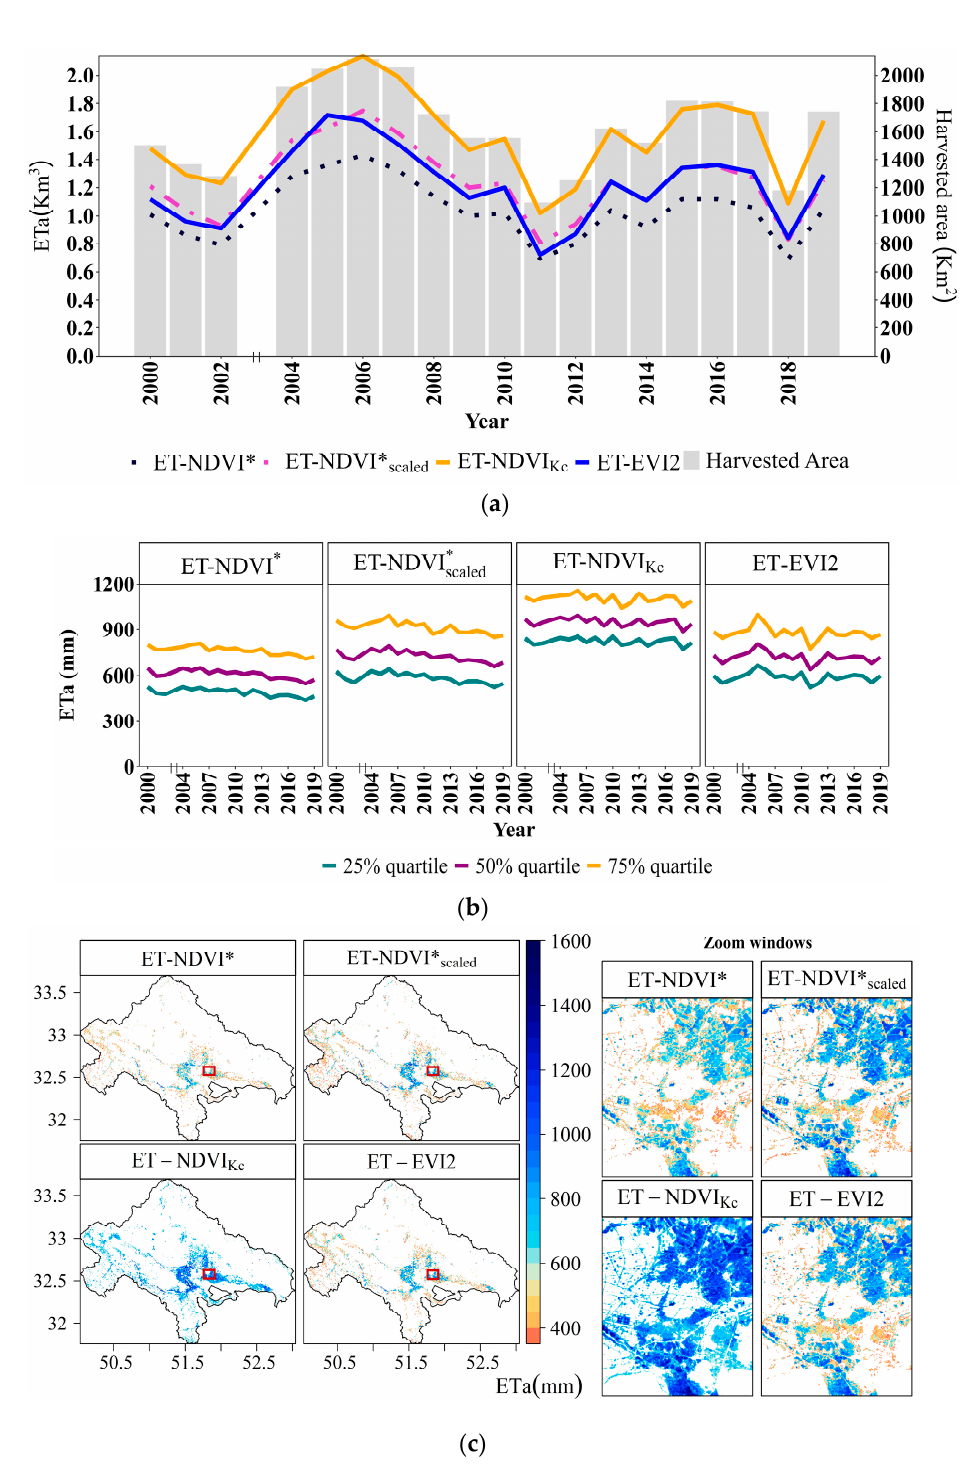
Figure 4. Comparison of ET-VIs, ( a ) Annual ET-VIs (volume in km 3 ) vs. cultivated area over time, ( b ) Annual ET-VIs’ first, median, and third quartile, and ( c ) Long-term ET-VIs’ map with zoom windows of the red boxes inside the maps have been shown on the left to better illustrate the differences between ET-VIs.